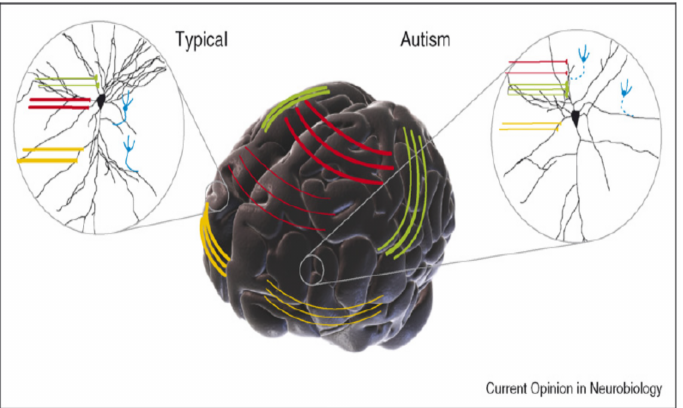
Figure 1. Definition of